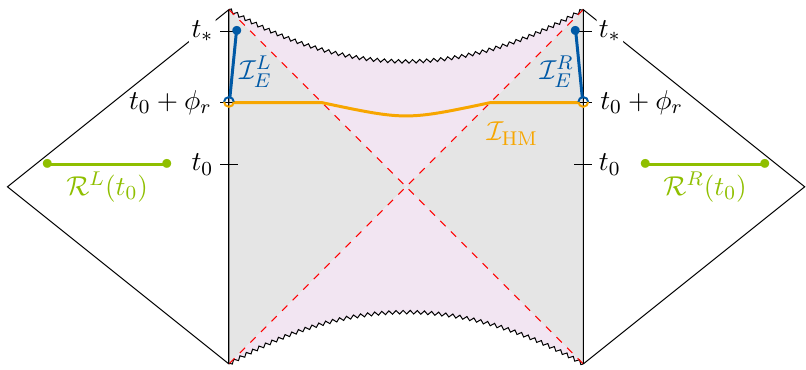
Figure 6 . The 2 -dimensional system, consisting of the black hole on the φ = 0 brane coupled to the bath on the conformal boundary. The radiation region is depicted in green and is the union of two disconnected pieces. The blue intervals comprise a sketch of the exterior islands, whereas the orange interval is a sketch of the Hartman-Maldacena island. We have taken ρ intervals approach the conformal boundary (a phenomenon represented by open dots) and thus include near-boundary degrees of